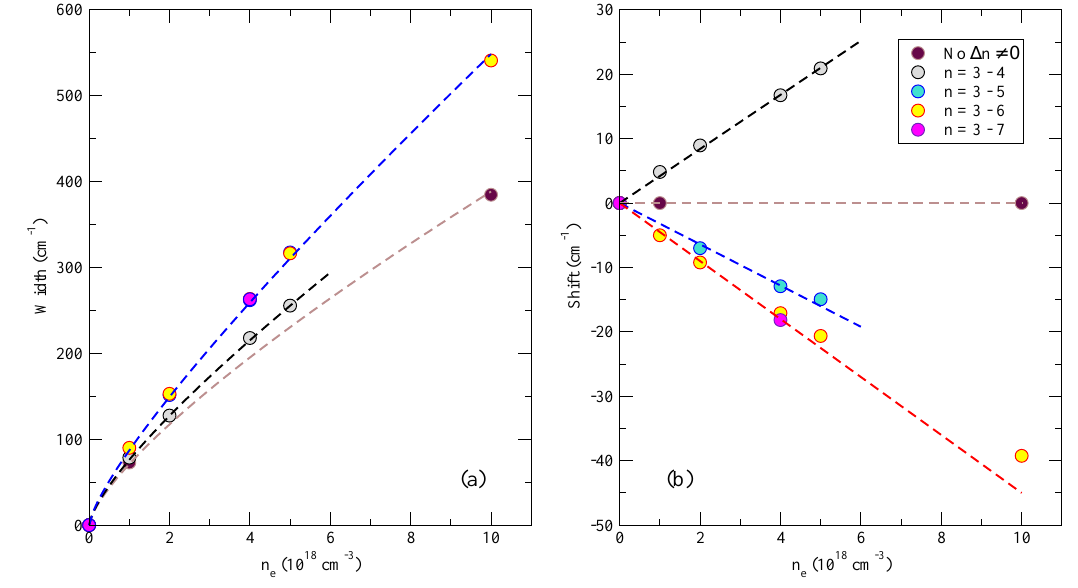
Figure 9. The influence of quenching on the Stark width ( a ) and shift ( b ), as calculated by SimU, assuming T =